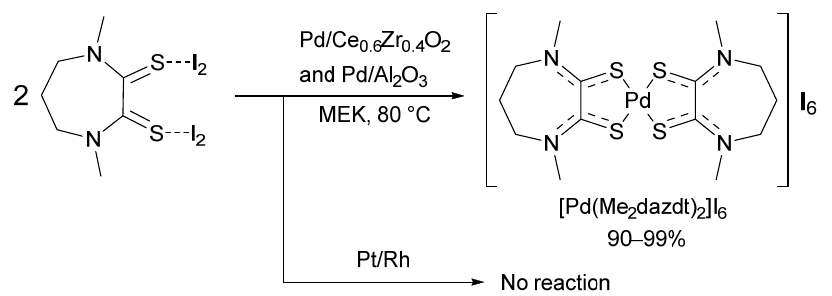
Figure 12. Recovery of palladium using Me 2 dazdt ∙ 2I 2 , Reproduced with permission from [100,102].